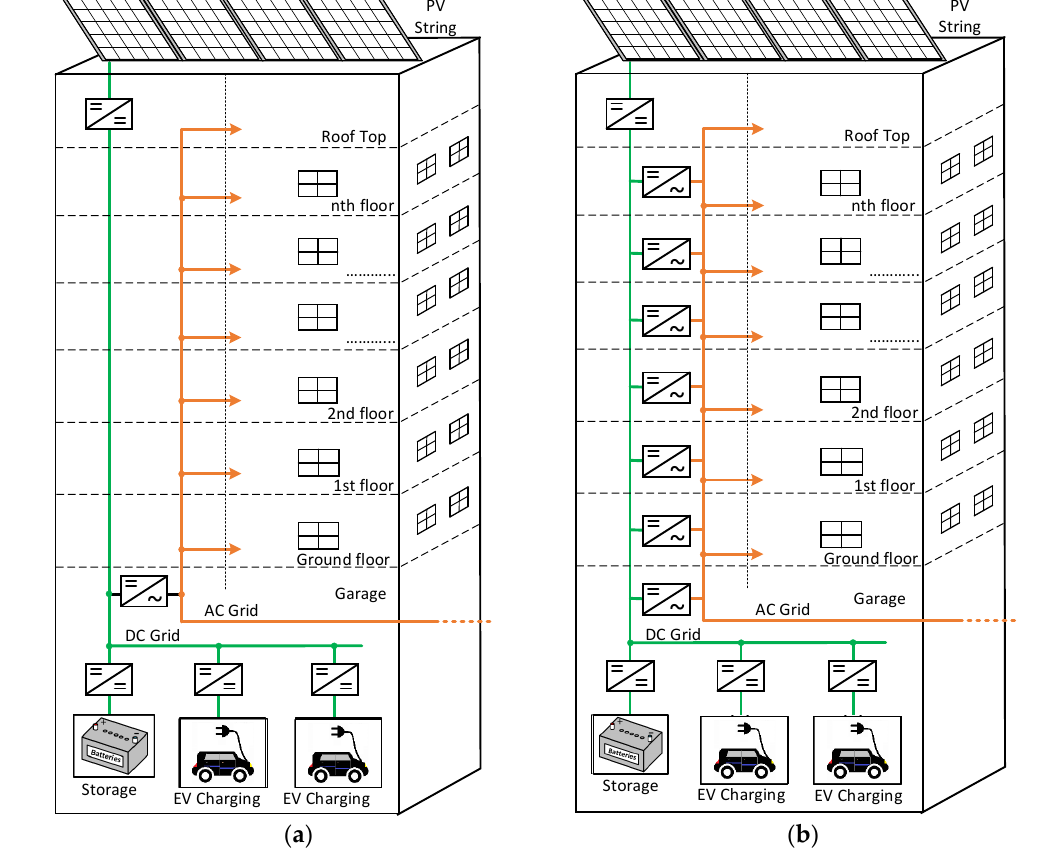
Figure 12. Possible structure of the electrical infrastructure of buildings in which only a DC infrastructure connects to the renewable energy generators, storage systems and the electric vehicles charging system: ( a ) only with one interconnection and ( b ) with more than one interconnection.